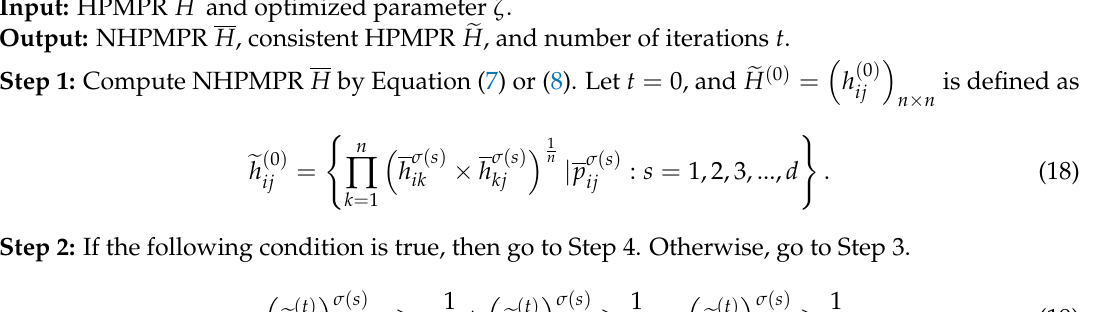
Algorithm 1 Algorithmic description to determine NHPMPR H , consistent HPMPR (cid:101) H ( t ) , and number of iterations t